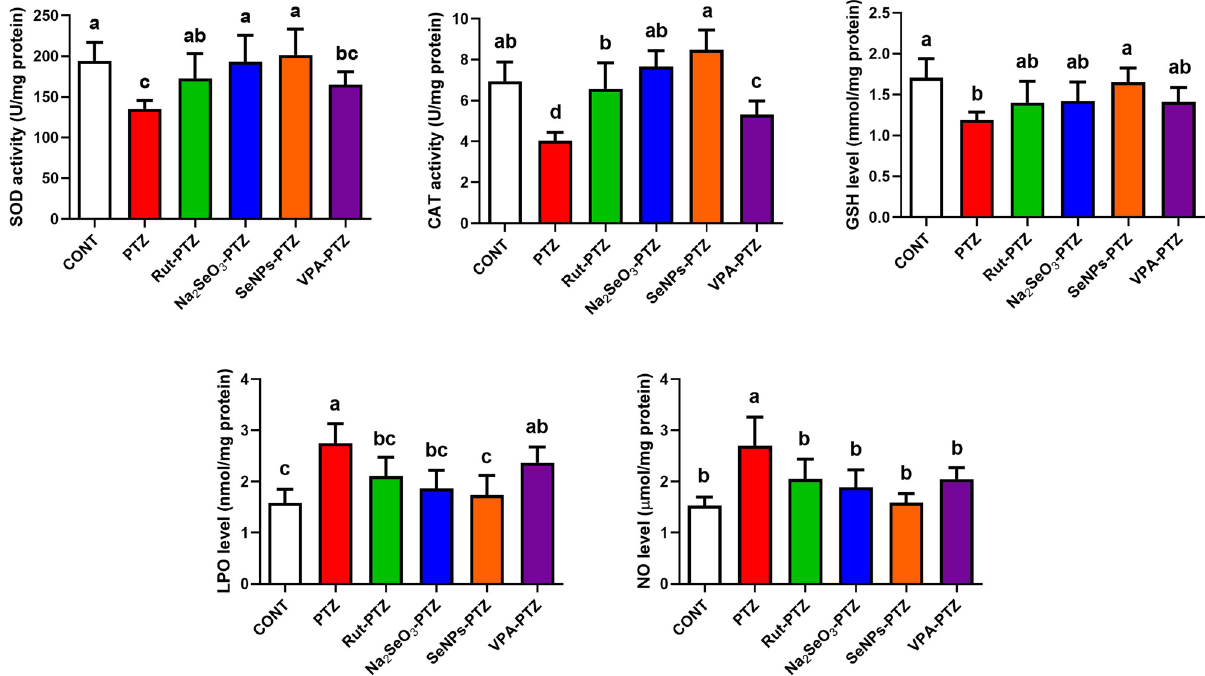
Figure 4: E ff ects of orally administered Rut, Na 2 SeO 3 , or Rut - SeNPs on the levels of SOD, CAT, GSH, NO, and MDA in the hippocampus of PTZ - injected epileptic mice. Di ff erent superscript letters indicate statistical signi fi cance at P < 0.05. All results are presented as the mean ±